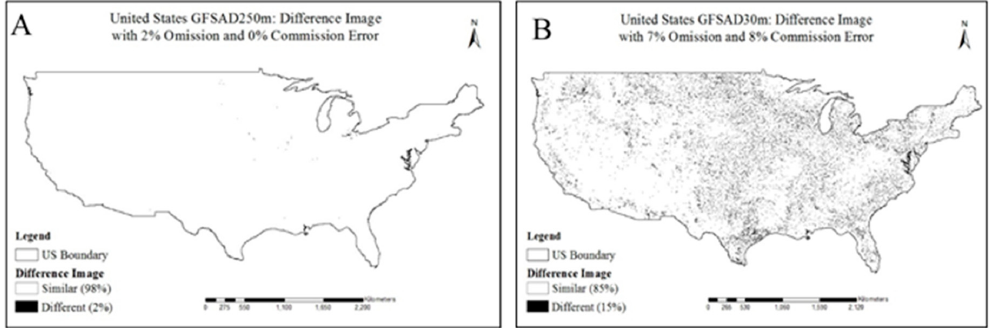
Figure 8. Difference images representing the disagreement in the GFSAD250m ( A ) and GFSAD30m ( B ) cropland extent map of the US as compared to the reference map.